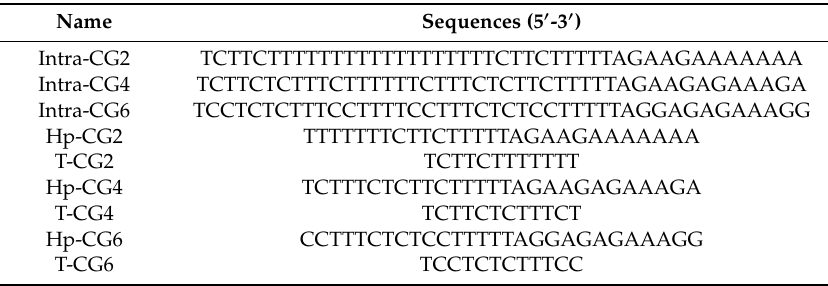
Table 1. Sequences used for triplex formation in this